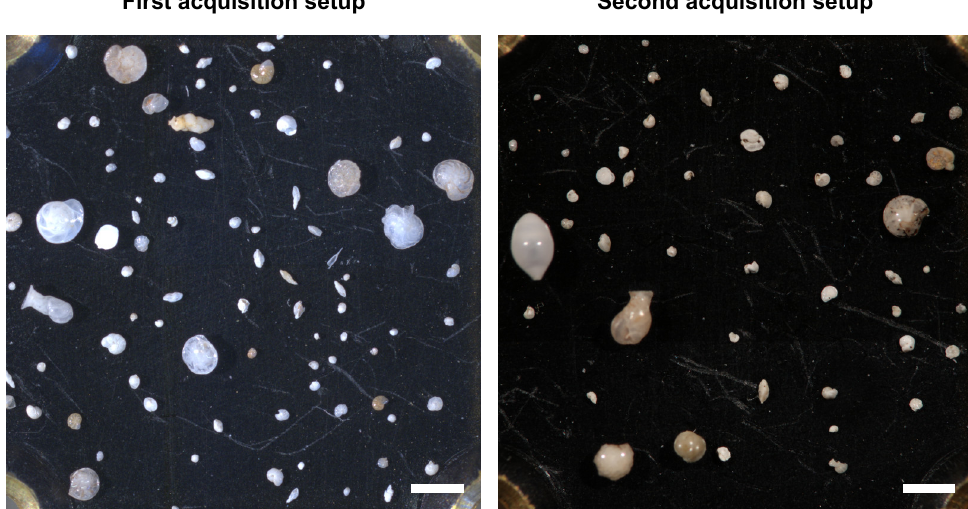
Figure 1. Examples of images from the two different image acquisition setups used during three data collection phases. The visible area in each image is approximately 10mm × 10mm and the scale bars correspond to 1000µm. ( Left ): Calcareous benthics photographed with the first acquisition setup used during the first data collection phase. ( Right ): Calcareous benthics photographed with the second acquisition setup used during the second and third data collection